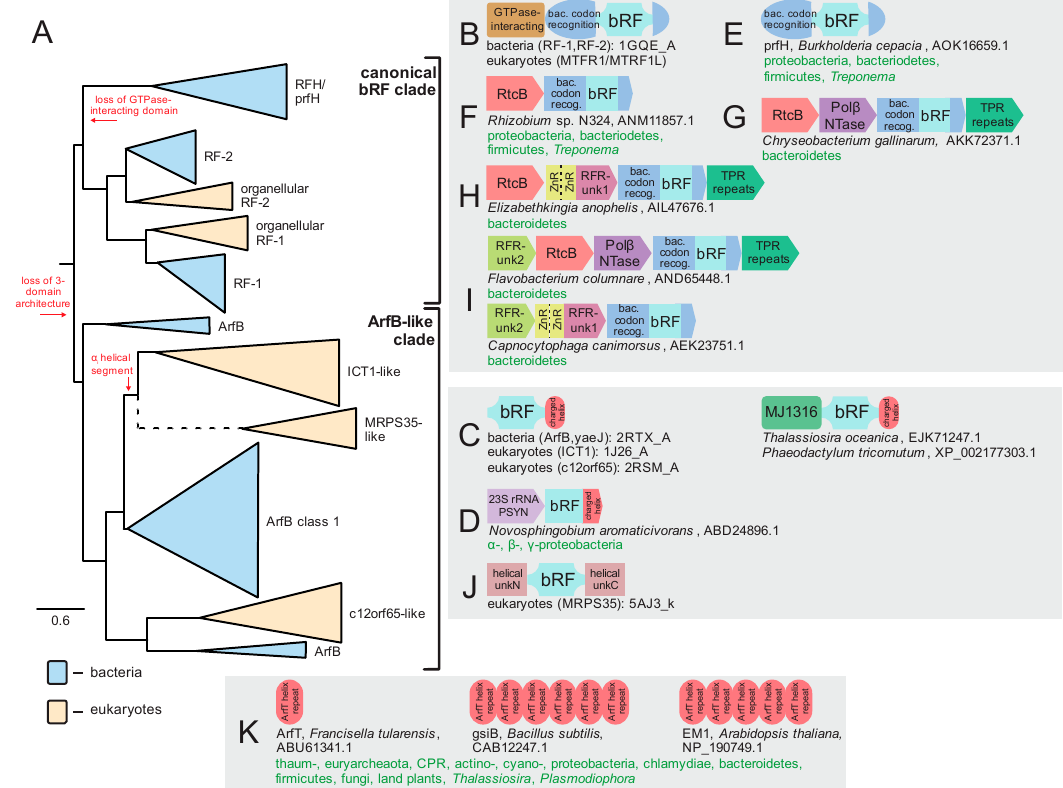
Figure 4. Evolution of bRF-PH domain with known domain architectures and conserved gene neighborhoods. ( A ) Collapsed phylogenetic tree depicting the radiation of the bRF-PH domains. Key transitions are denoted in red lettering along the tree. ( B–K ) Notable domain architectures and conserved gene neighborhoods. See Figure 3 legend for further descriptions and details. Abbreviations: PSYN, pseudouridine synthase; RFR, RFH and RtcB-associating unknown domains; bac. codon recog., bacterial codon recognition